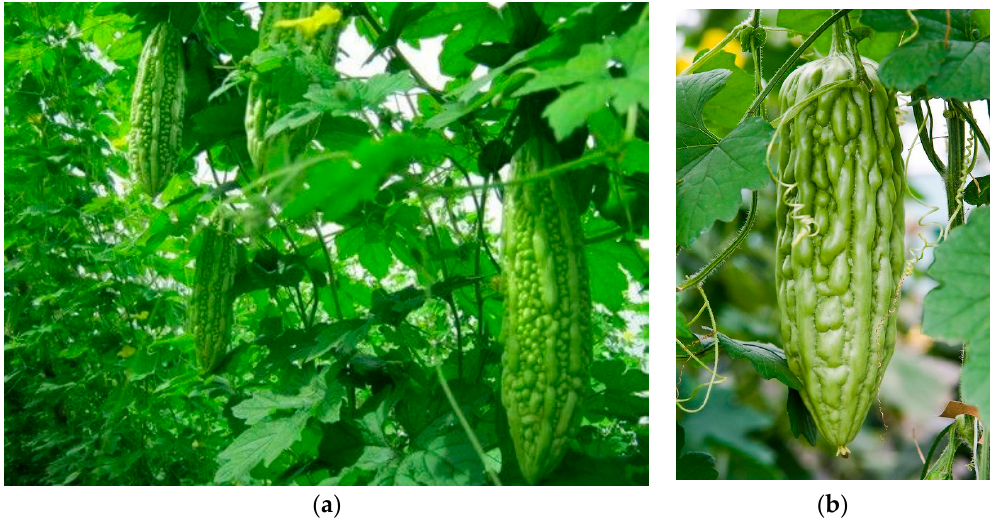
Figure 3. Pictures show the morphological characteristics of the Momordica charantia (MC): ( a ) whole plant and ( b ) unripe